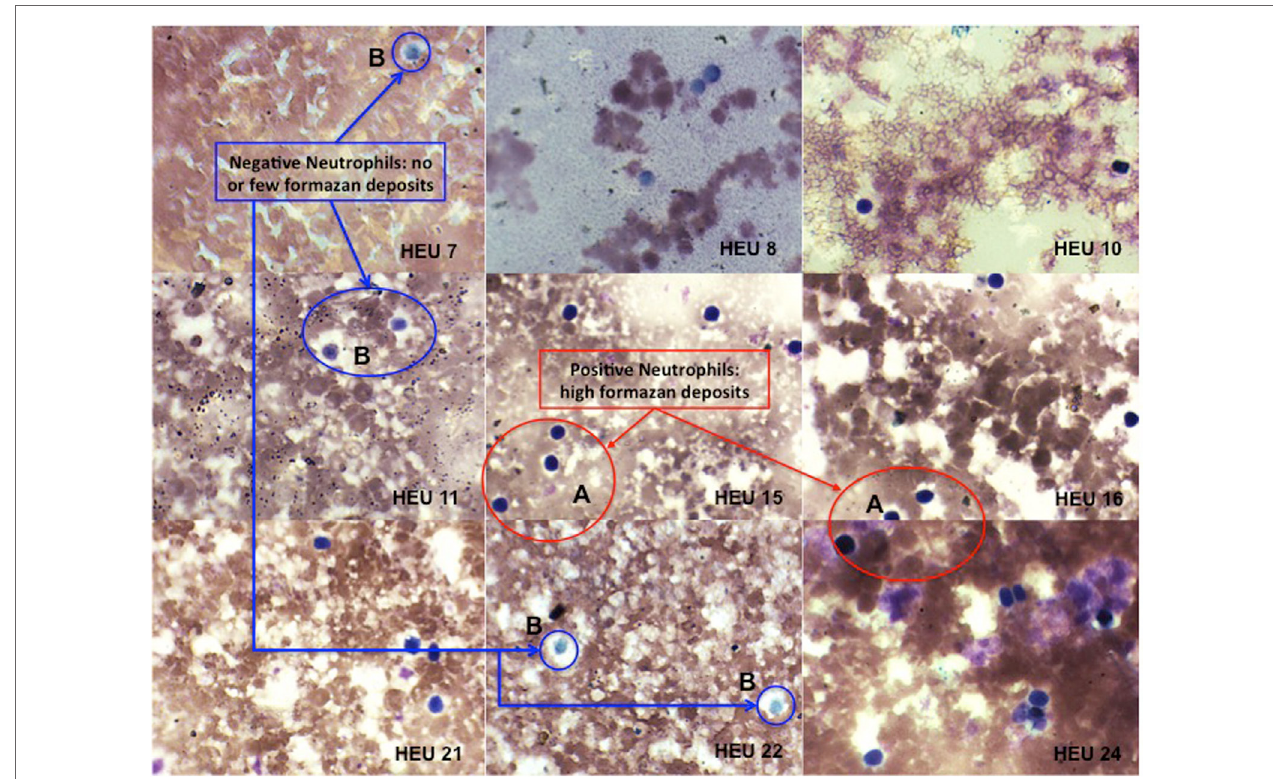
FigUre 1 | Photomicrographs of nitroblue tetrazolium (nBT) dye reduction by blood neutrophils from heU infants (at × 100 magnification) . Positive = neutrophils contain increased formazan deposits visible as a large dark purple to black intra-cytoplasmic inclusions (a) . Negative = neutrophils contain few or no formazan deposits (B)